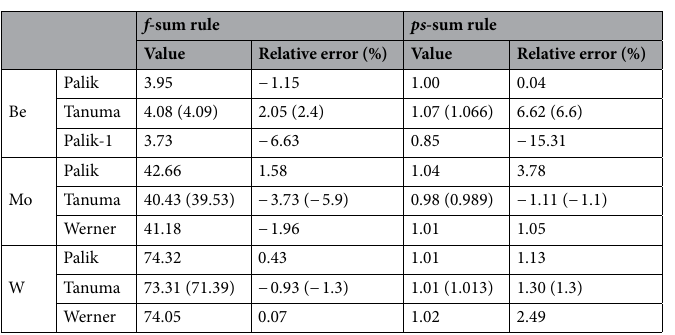
Table. 3. The f - and ps -sum rules and their relative errors for Be, Mo and W, where the data in parentheses were from Tanuma et al. 45 .